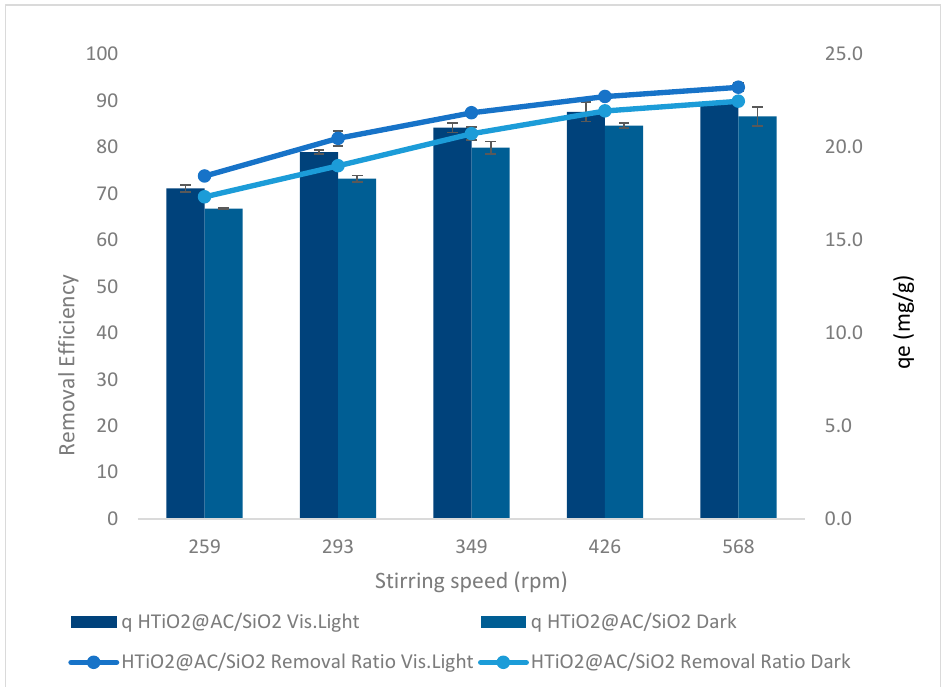
Figure 9. The effect of stirrer rate on oxamyl adsorption, using HTiO 2 @AC/SiO 2 in dark and visible light.